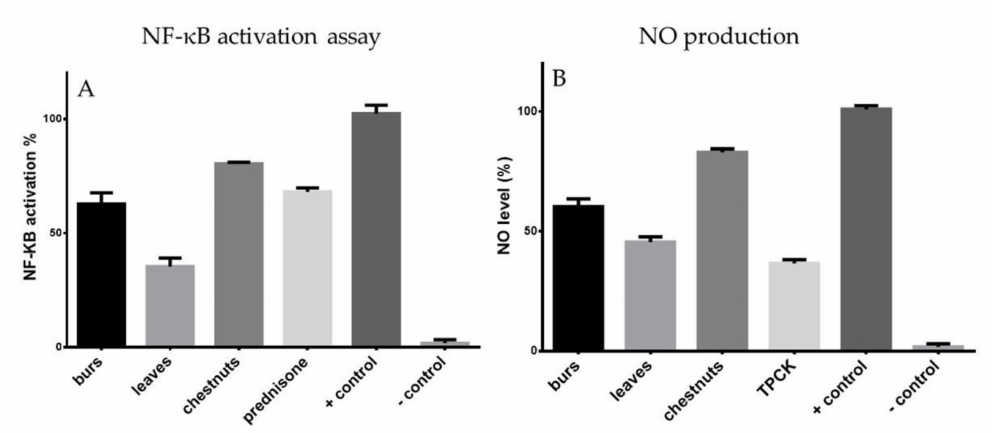
Figure 2. Anti-inflammatory activity of the MeOH extract of C. sativa (Marrone di Roccadaspide) leaves, burs, and chestnuts by in vitro nuclear factor-kappa B (NF- κ B) activation assay ( A ) and nitric oxide (NO) production assay ( B ). Results are expressed as mean ± SE for three indepen- dent experiments. Significant difference in comparison to vehicle only treated cells ( p <